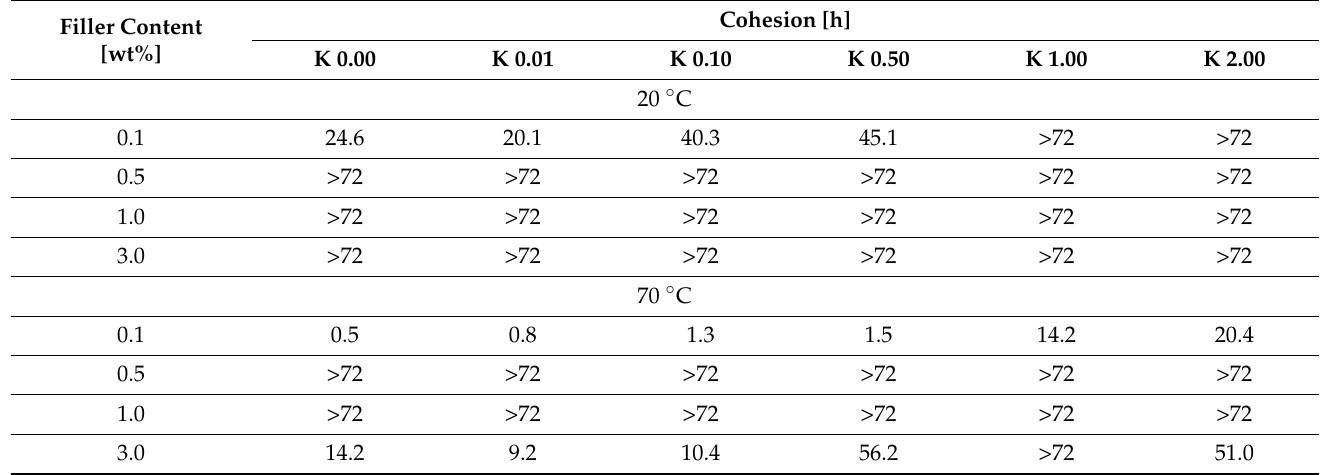
Table 5. Cohesion at 20 and 70 ◦ C of Q2-7358 resin-based adhesives with clinoptilolite.